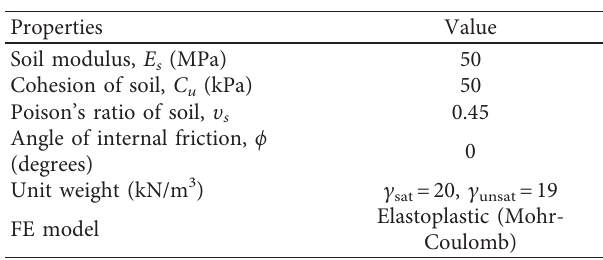
Table 1: Soil properties.